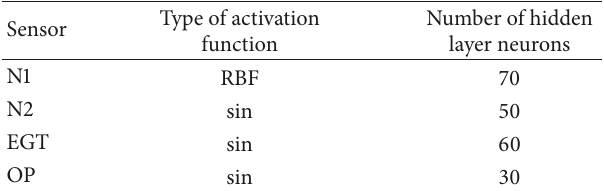
Table 1: Activation function and the number of hidden nodes for each